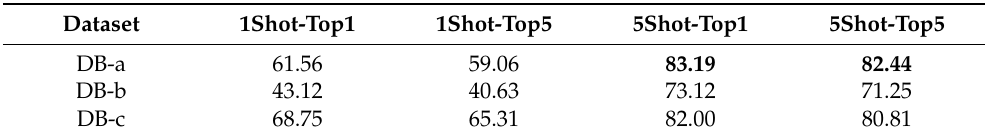
Table 4. 5-way 1-shot and 5-way 5-shot Classification top 1 and top 5 accuracy (%) for new subject on CapgMyo with MAML. The meta batch size is set to 64. The boldface numbers represent the best classification accuracies for each dataset compared with Table 3.